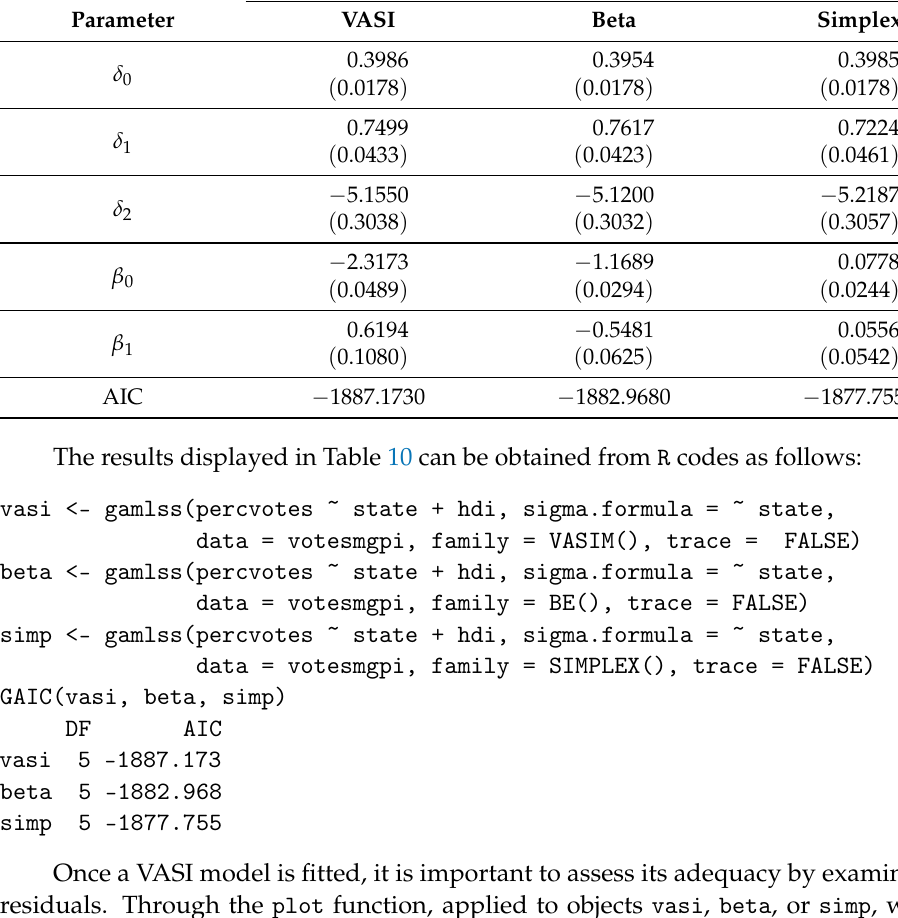
Table 10. ML estimates (with SEs in parentheses) and AIC values for the vote data.